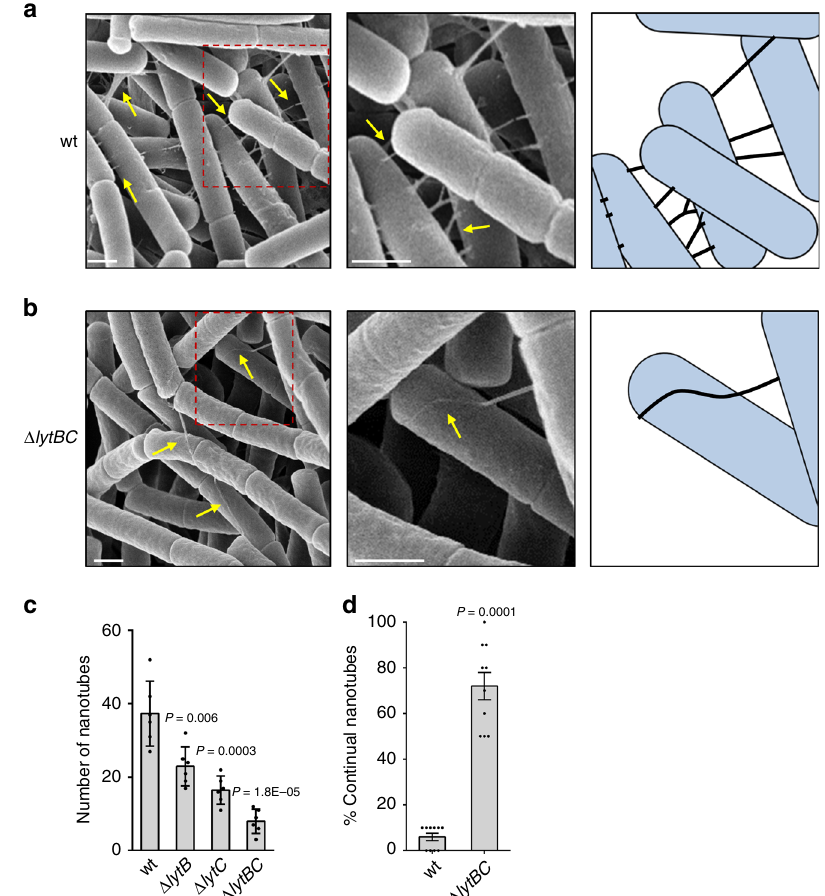
Fig. 1 LytB and LytC impact nanotube extrusion and penetration. a , b Bs wt (GD215: Δ hag ) ( a ) and Δ lytBC (AB64: Δ lytBC , Δ hag ) ( b ) strains were grown to mid logarithmic phase, spotted onto EM grids, incubated on LB agar plates for 4 h at 37 °C, and visualized by XHR-SEM. Shown are typical fi elds of cells (left panels), enlargements of the boxed regions (middle panels), and schematics that depict the interpretive cell layout and highlight intercellular nanotube patterns (right panels). Arrows indicate intercellular nanotubes. Scale bars represent 500 nm. c Quanti fi cation of the number of nanotubes displayed per 50 cells. Bs wt (GD215 Δ hag ), Δ lytB (AB232: Δ lytB , Δ hag ), Δ lytC (AB62: Δ lytC , Δ hag ), and Δ lytBC (AB64: Δ lytBC , Δ hag ) strains were subjected to XHR- SEM analysis as described in a , b . Shown are mean ± SEM and P values (unpaired Student ’ s t test) of at least three independent experiments ( n cells = 300). d Quanti fi cation of the average percentage of continual nanotubes displayed by Bs wt (GD215) and Δ lytBC (AB64) strains following XHR-SEM analysis as described in a , b . Shown are mean ± SEM and P values (unpaired Student ’ s t test) of at least three independent experiments. ( n nanotubes = 150). Source data are provided as a Source Data fi